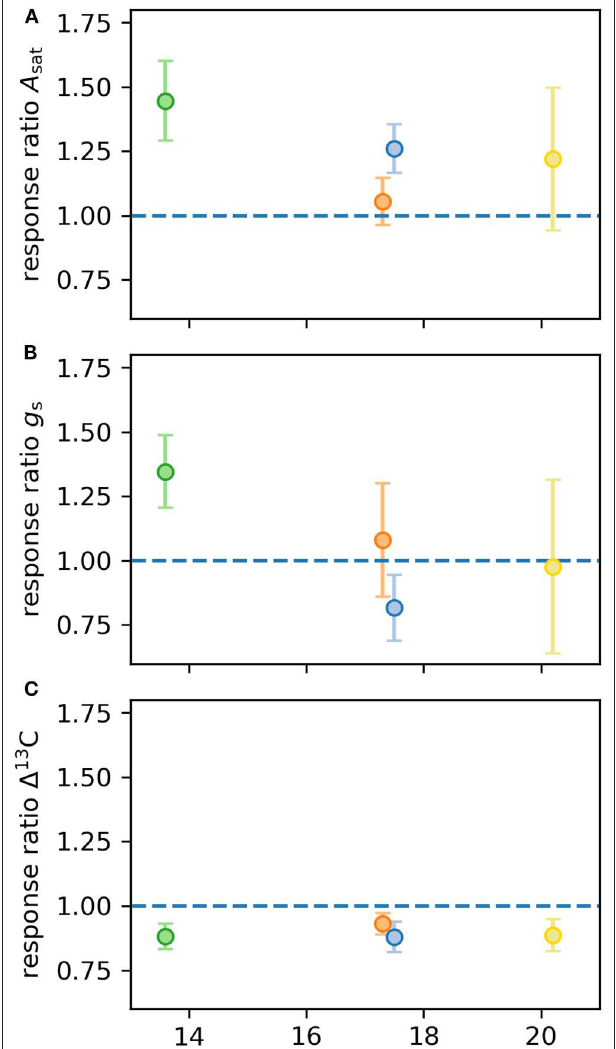
FIGURE 3 | Response ratios of leaf physiological traits calculated for Experiment 1. Response ratios represent differences in four different provenances of E. grandis grown under eCO 2 compared to aCO 2 ( n = 5 per provenance and [CO 2 ] treatment). Traits: light-saturated photosynthetic carbon assimilation ( A sat ; A ), stomatal conductance ( g s ; B ), carbon isotope discrimination ( 1 13 C; C ). Error bars represent 1SE.